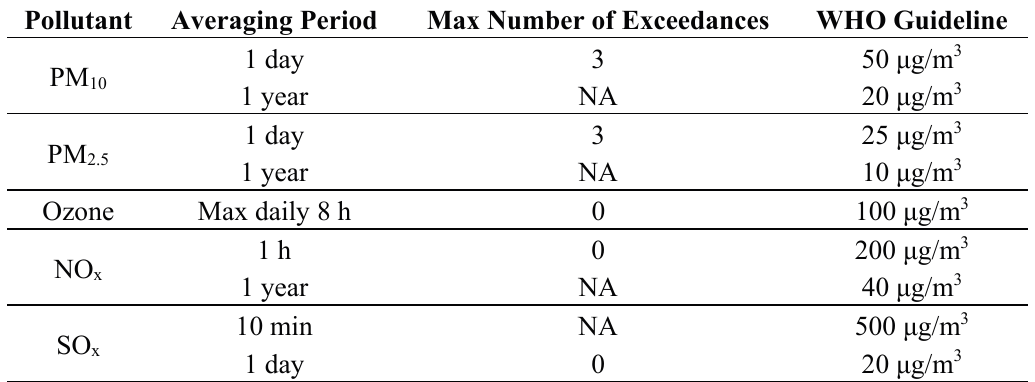
Table 1. World Health Organization (WHO) guidelines (2006) for most important, monitored air